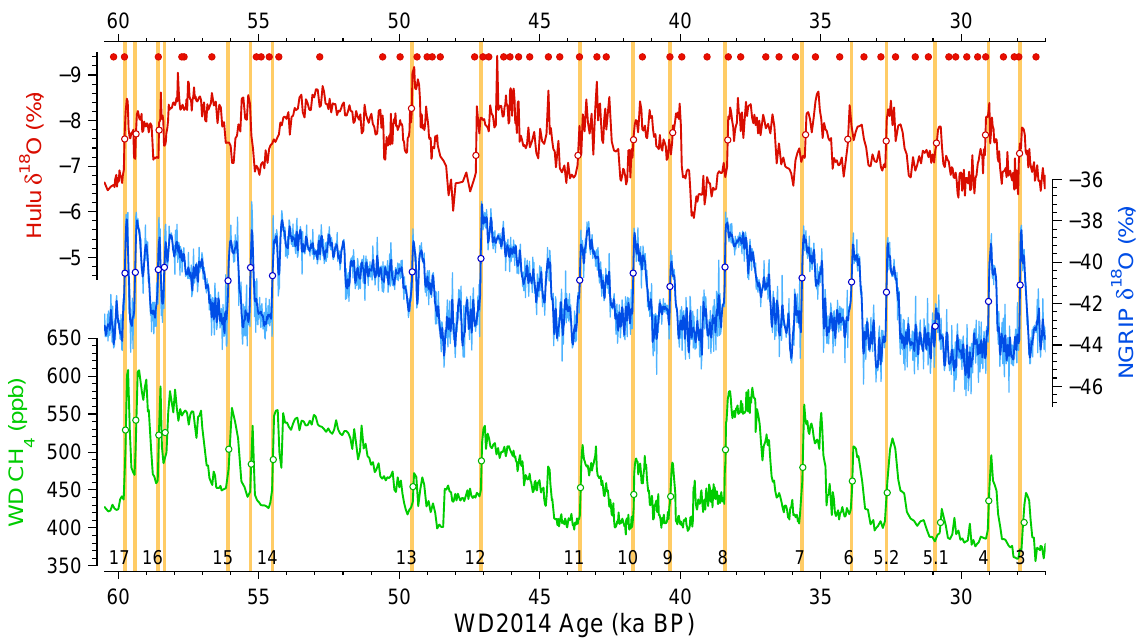
Figure 5. Records of abrupt DO climate variability, (a) revised Hulu Cave speleothem δ 18 O record on Hulu chronology with U / Th ages above the time series (red dots), (b) NGRIP ice core δ 18 O on 1 . 0063 × GICC05 chronology, and (c) WD CH 4 on WD2014 (discrete data). DO numbering is given in the bottom of the figure following Rasmussen et al. (2014). White dots denote the midpoints of the stadial–interstadial transitions; the orange vertical lines show the timing of the NGRIP tie points (on 1 . 0063 × GICC05). For DO 3, 4, and 5.1 the WD2014 chronology is based on annual-layer counting, and minor timing differences exist between WD and